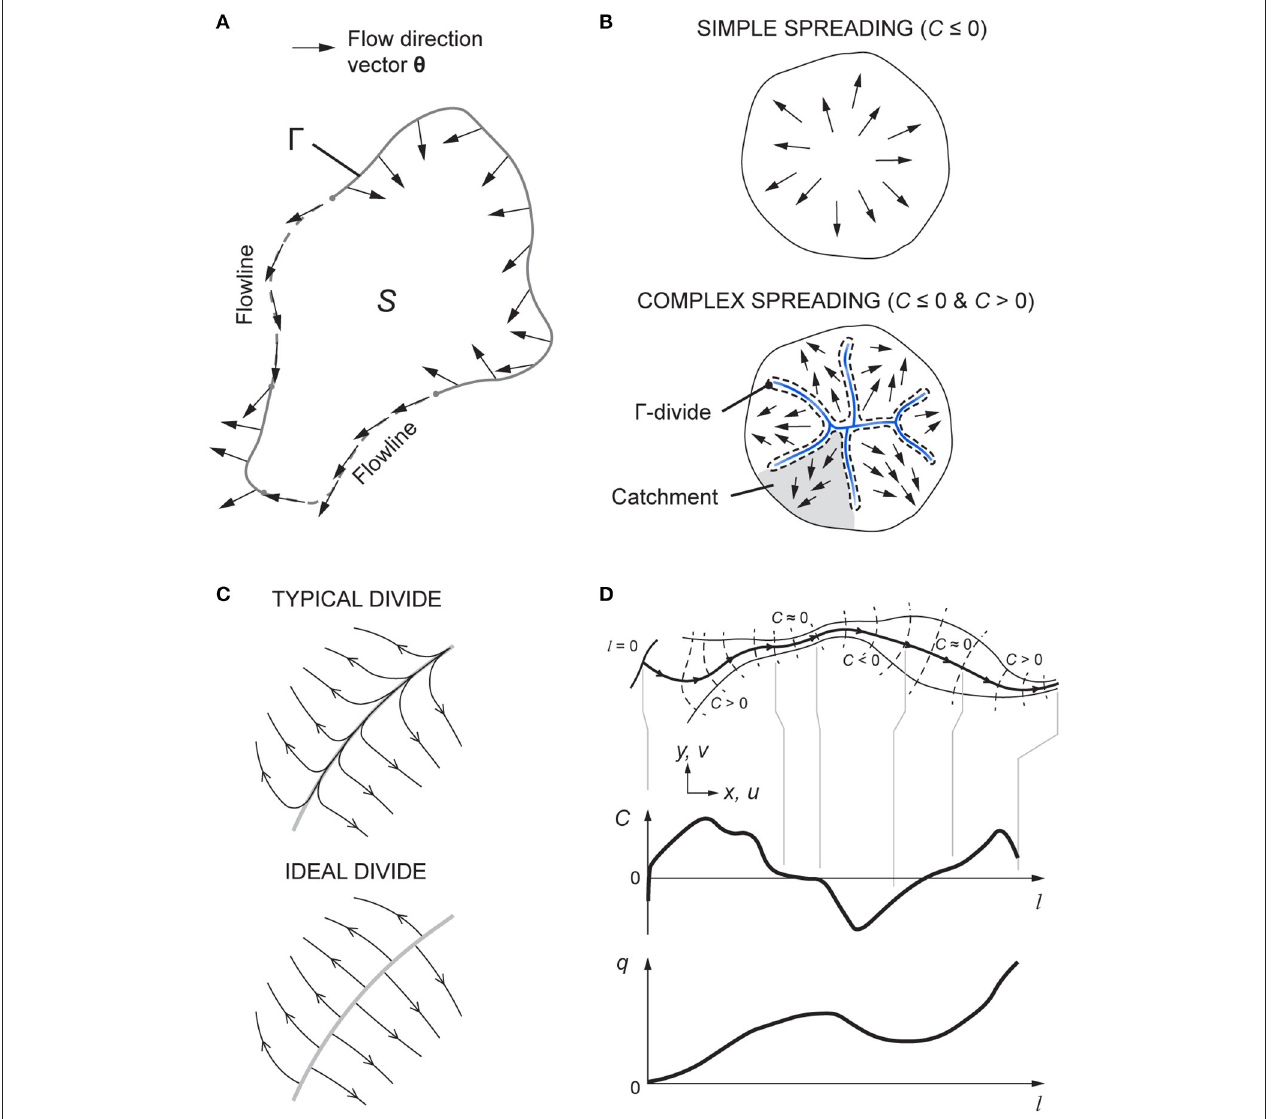
FIGURE 2 | Anatomy of the flow-direction field and flowline system. (A) Test area for the convergence integral in Equation (7). (B) Symmetry-breaking transition from simple to complex ice-sheet flow. (C) Flowline configurations in the neighborhood of ice divides. (D) Accumulation of ice-flux density q on a flowline controlled by varying convergence and divergence along its